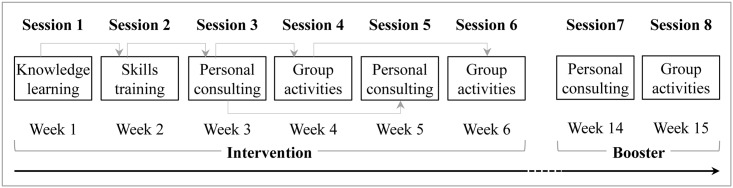
Scheduling of Program Delivery for the KM2H2.